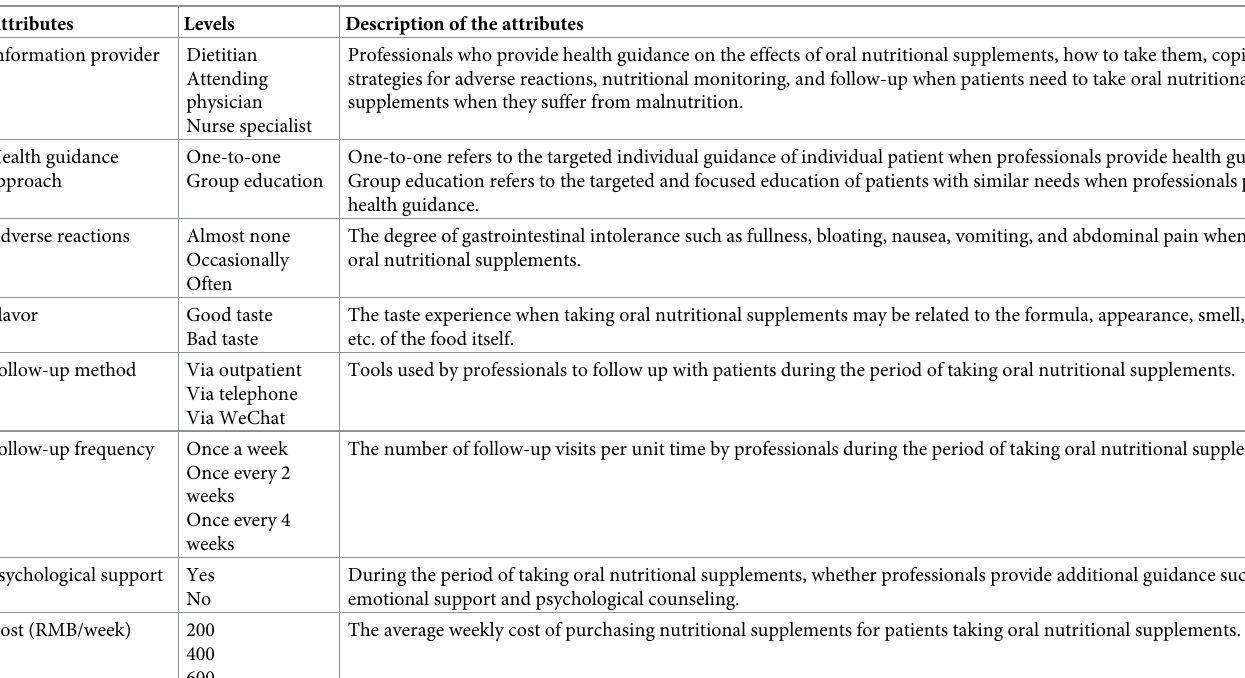
Table 5. List of final attributes and